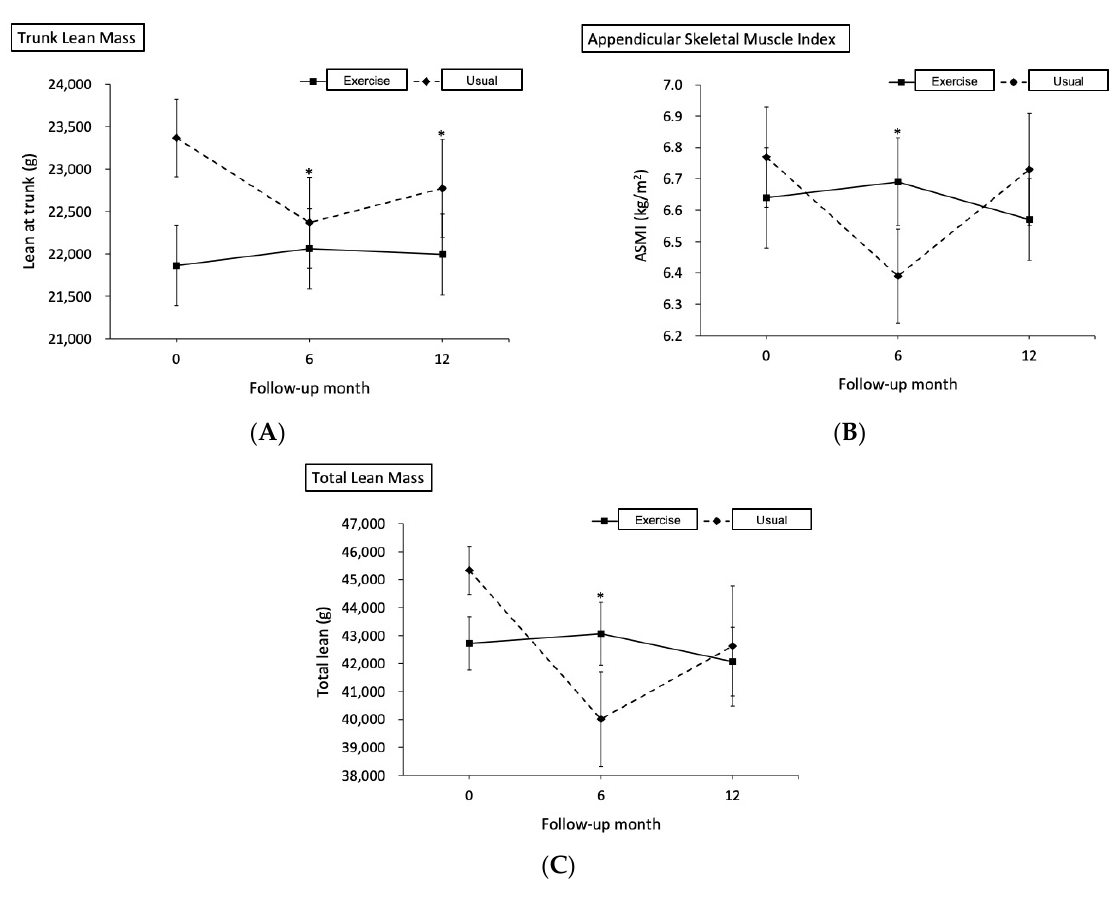
Figure 1. During the initial six months of androgen deprivation therapy, there was a significant increase in ( A ) trunk lean mass, ( B ) appendicular skeletal muscle index, and ( C ) total lean mass in the exercise group as compared to the usual